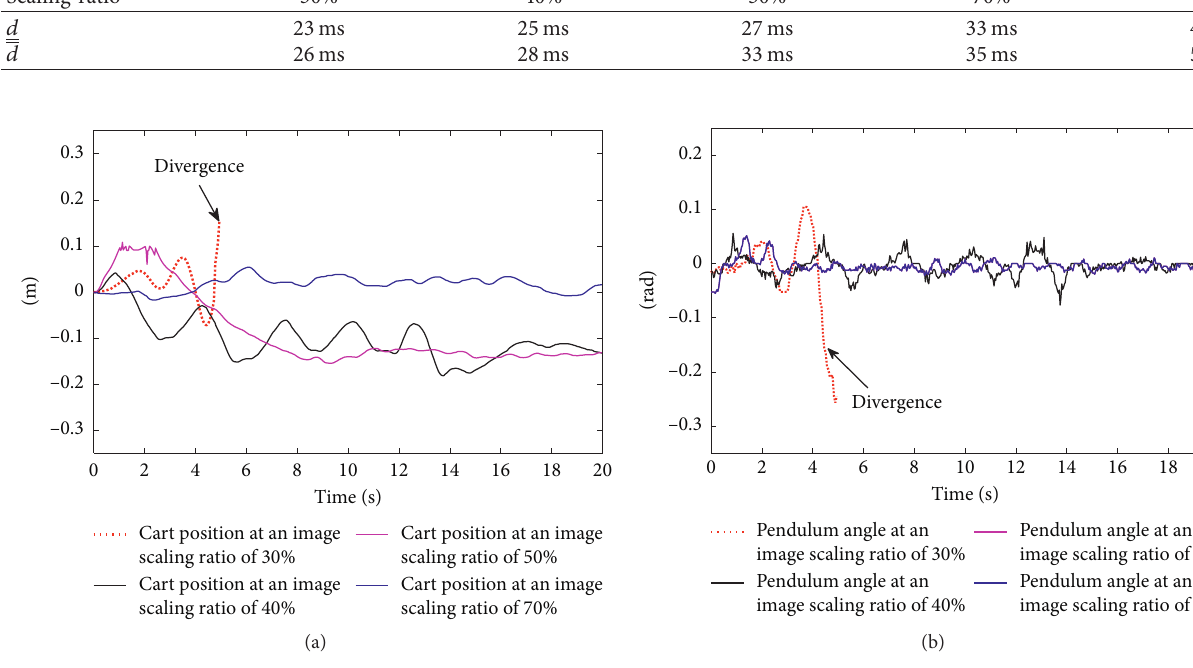
Figure 11: Real-time control under different image scaling ratios (no attack).